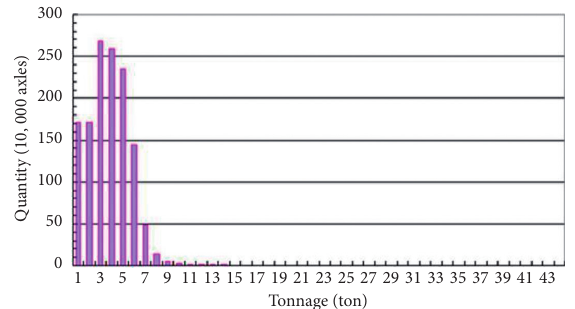
Figure 7: Single-axle and double-wheel load spectrum.